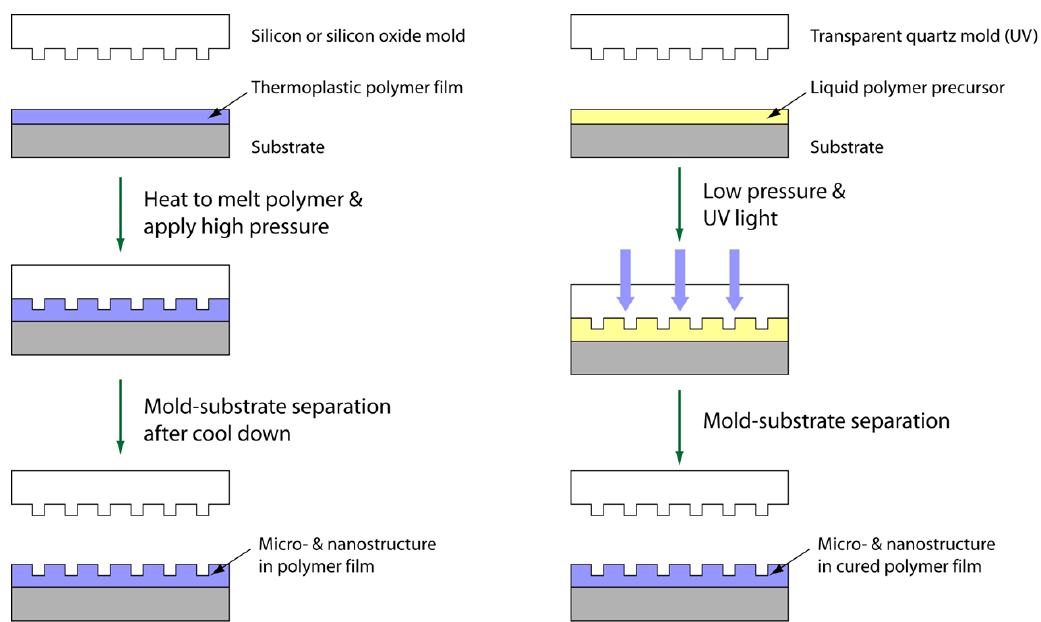
Figure 1. Schematic overview of thermal nanoimprint lithography (NIL) ( left ) and UV-NIL ( right ) processes. The separation between the mold and the micro/nanostructured polymer film in the last step is termed demolding.